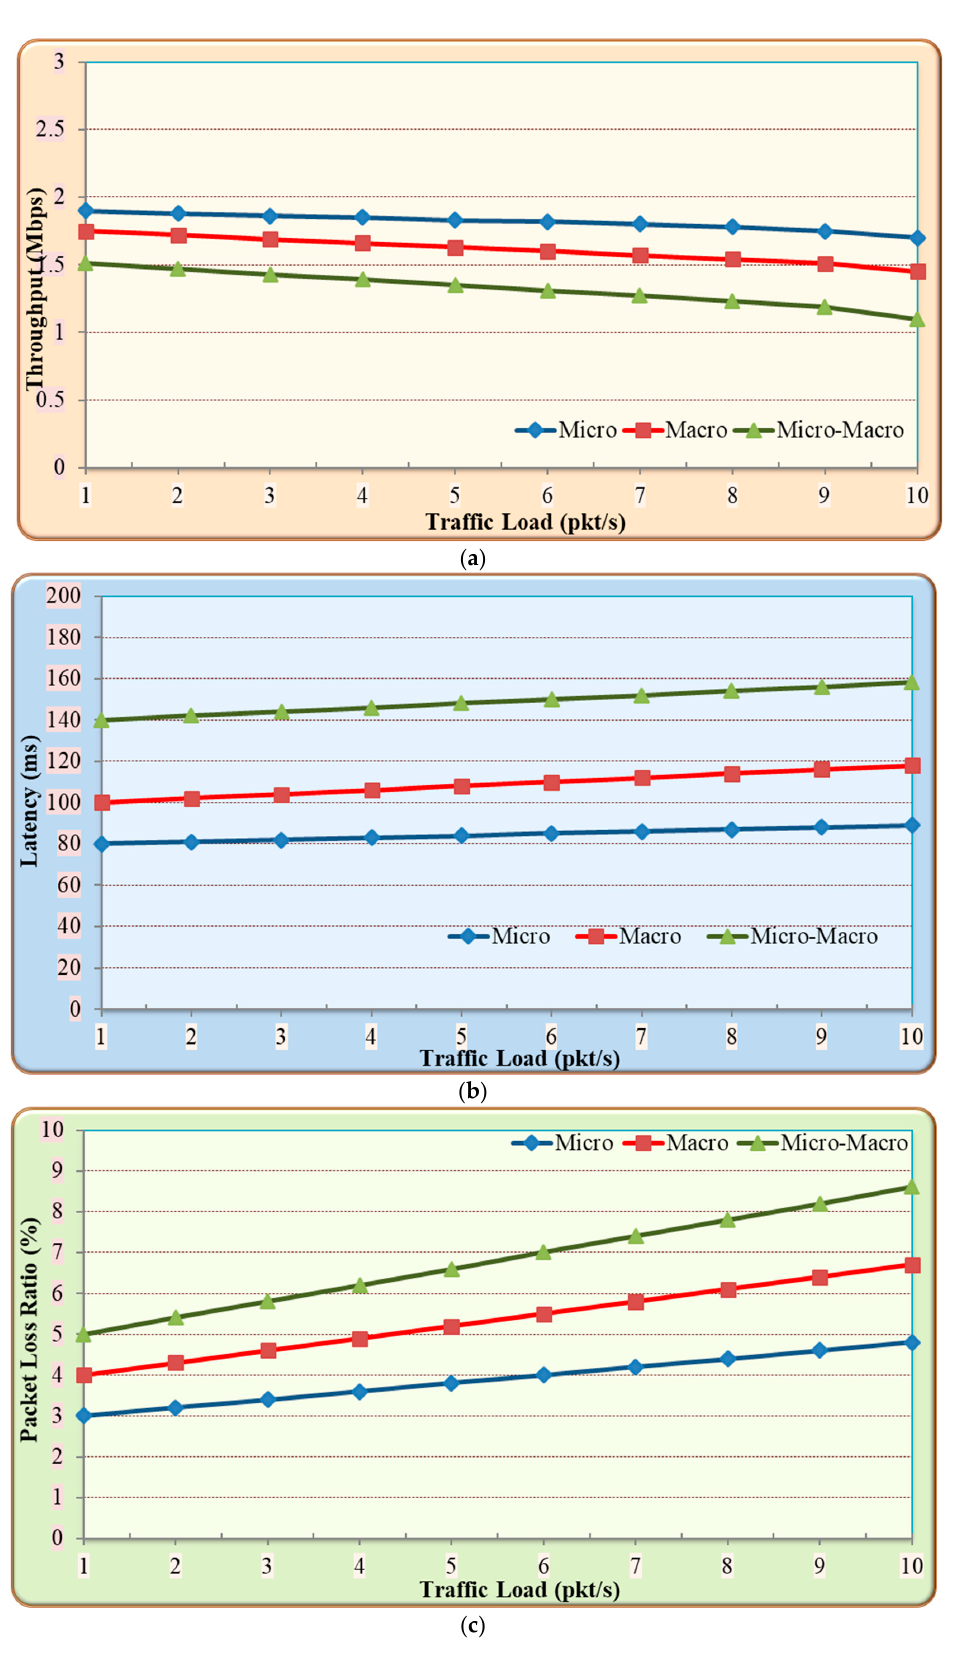
Figure 7. Impact of CMA authentication algorithms on IoT Performance ( a ) throughput; ( b ) latency; ( c ) packet loss